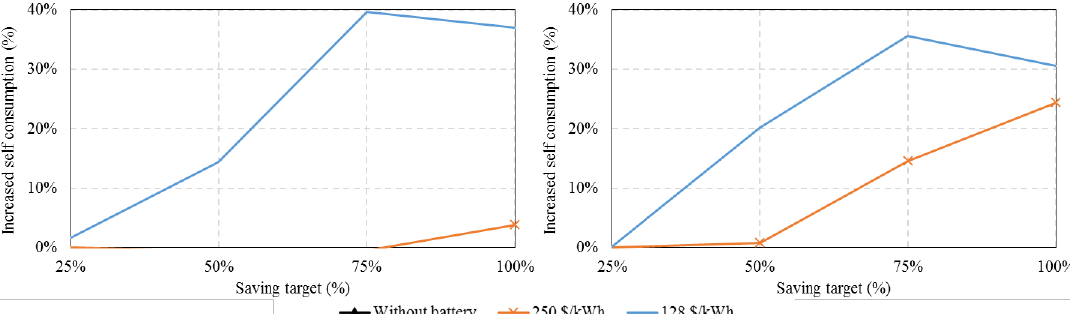
Figure 17. Increased the self-consumption percentage points of the PV system due to use a battery of the optimal capacity versus the saving targets, for feed-in tariff =6.7 ₵ /kWh ( left ), and 3.35 ₵ /kWh ( right ).